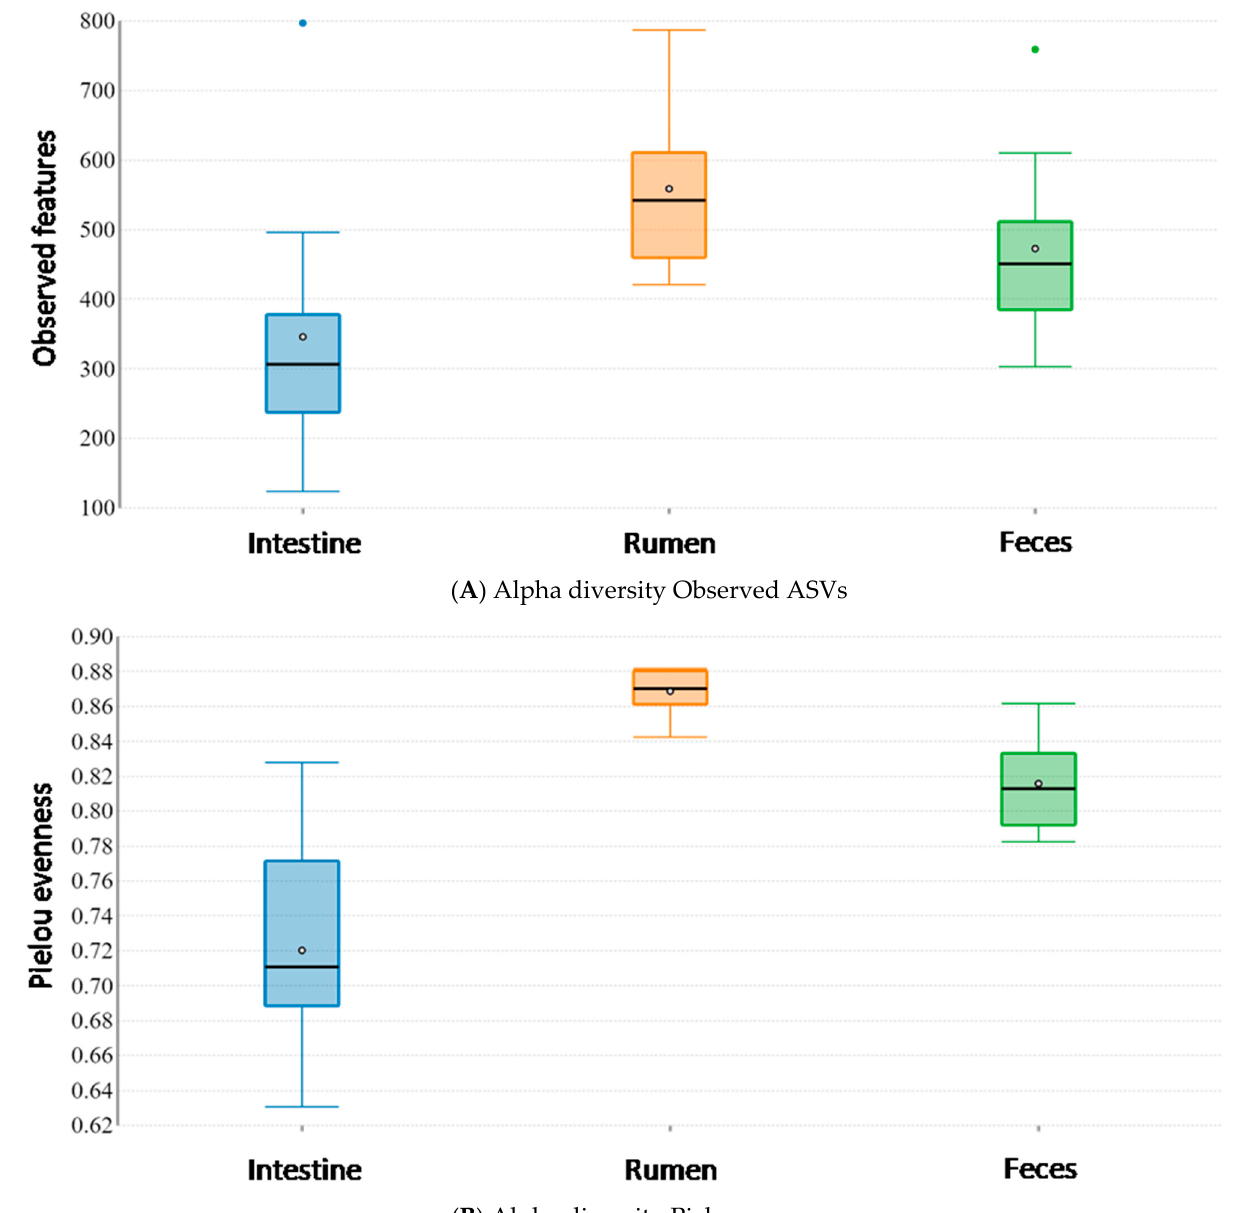
Figure 3. Alpha diversity analysis among the rumen, large intestine and feces from traditionally fed water buffaloes ( n = 10). Differences in alpha diversity metrics among different body sites: ( A ) Observed ASVs; ( B ) Pielou evenness index.